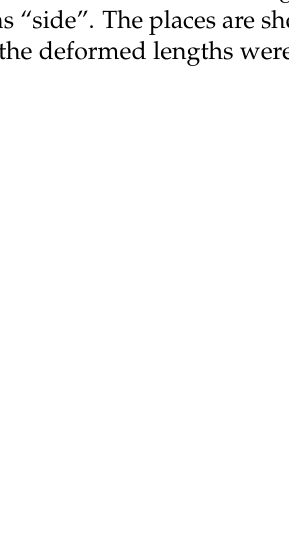
Figure 2. Positions of the three places where the concentration of the redistributed oil was measured under static strain.